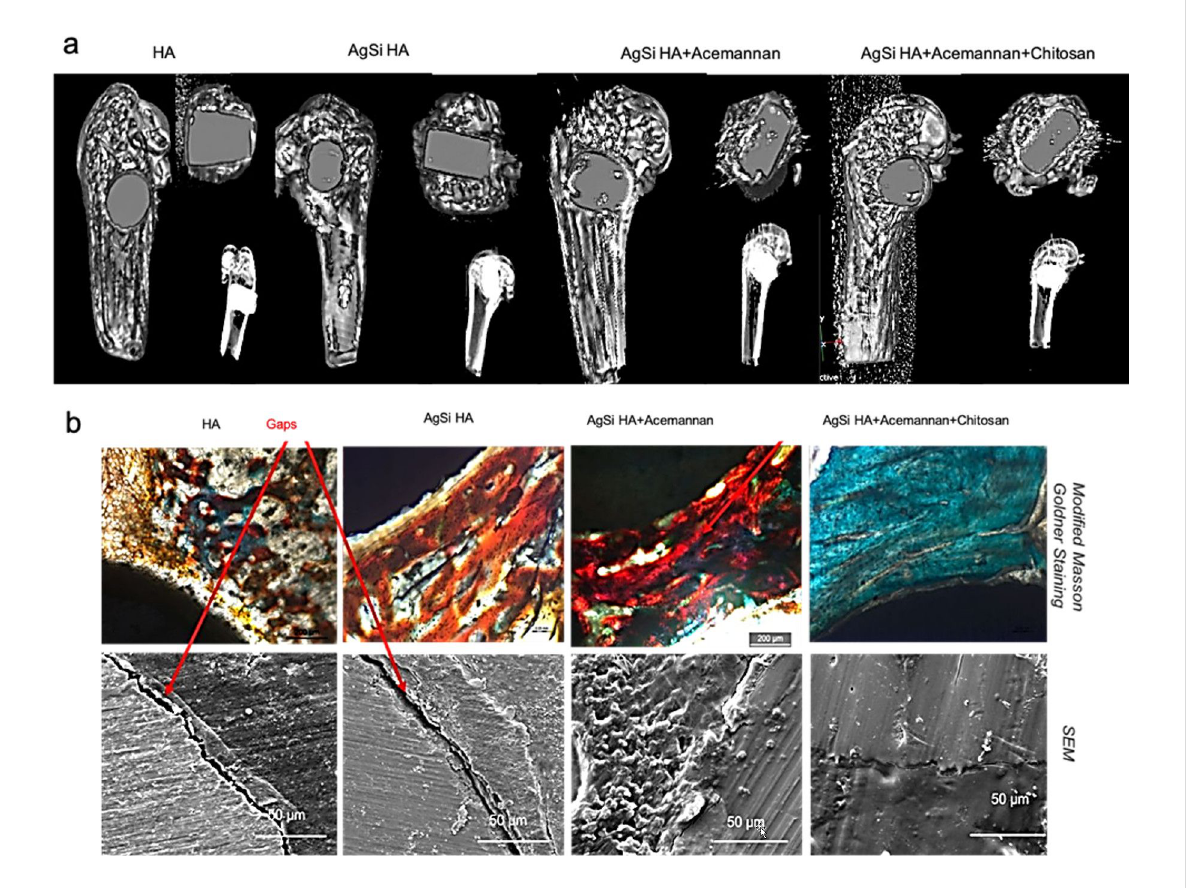
Figure 2: The in vivo development of new bone in a rat distal femur model five weeks after implantation. Figure 2a depicts 3D pictures created by computed tomography (CT) scan radiographs which show good bone lodging in all implants. There are noticeable holes at the hydroxyapatite implant interface. Ag–Si hydroxyapatite implants, on the other hand, have a smooth contact between the host bone and the implant. Acemannan and chitosan coatings have been detected. Figure 2b depicts an optical microscopy image of Masson-Goldner staining which shows that acemannan and chitosan accelerates the formation of new bone. Figure 2 was reprinted with permission from [99], Copyright 2019 American Chemical Society. This content is not subject to CC BY